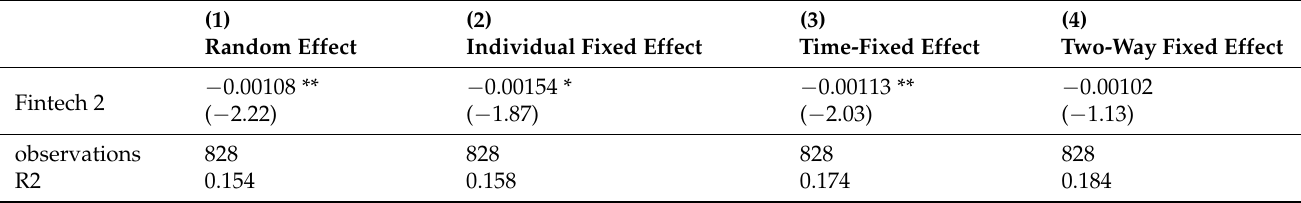
Table 7. Robustness test: replace the core explanatory variable with Fintech 2.